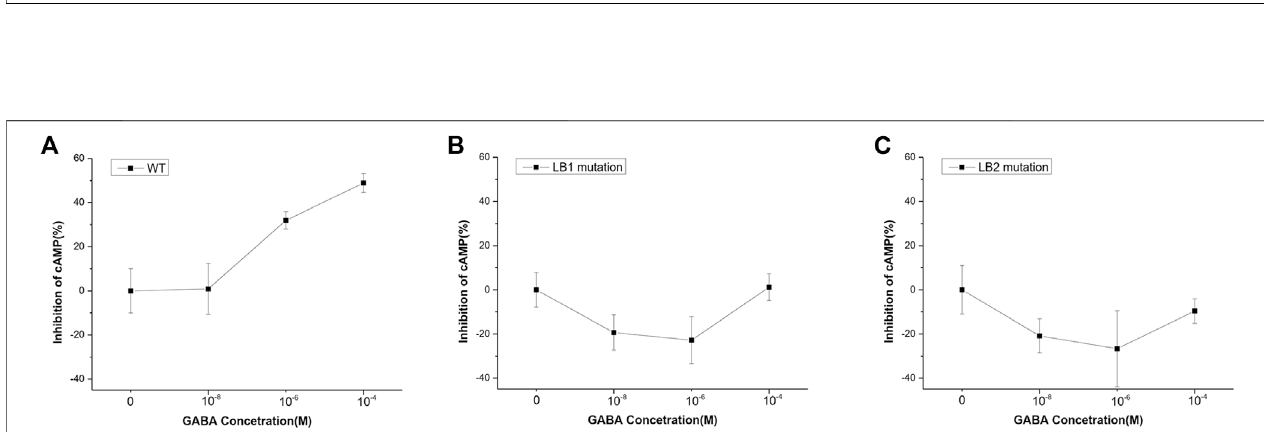
FIGURE 4| Mutant GBR1M and GBR2M inhibited receptor activation. (A) The inhibition effect of HEK293 cells transfected with wild-type GBR1 and GBR2, or (B) GBR1MandGBR2M (B) ,or (C) GBR1ndGBR2withLB2mutationunderdifferentconcentrationofGABA.BothmutationsinLB1 (B) andLB2 (C) couldseriouslyaffect the function of the receptor. The ligand concentrations used in the experiment were (from high to low) 10 − 4 , 10 − 5 , 10 − 6 , 10 − 7 , 10 − 8 , and 10 − 9 M.